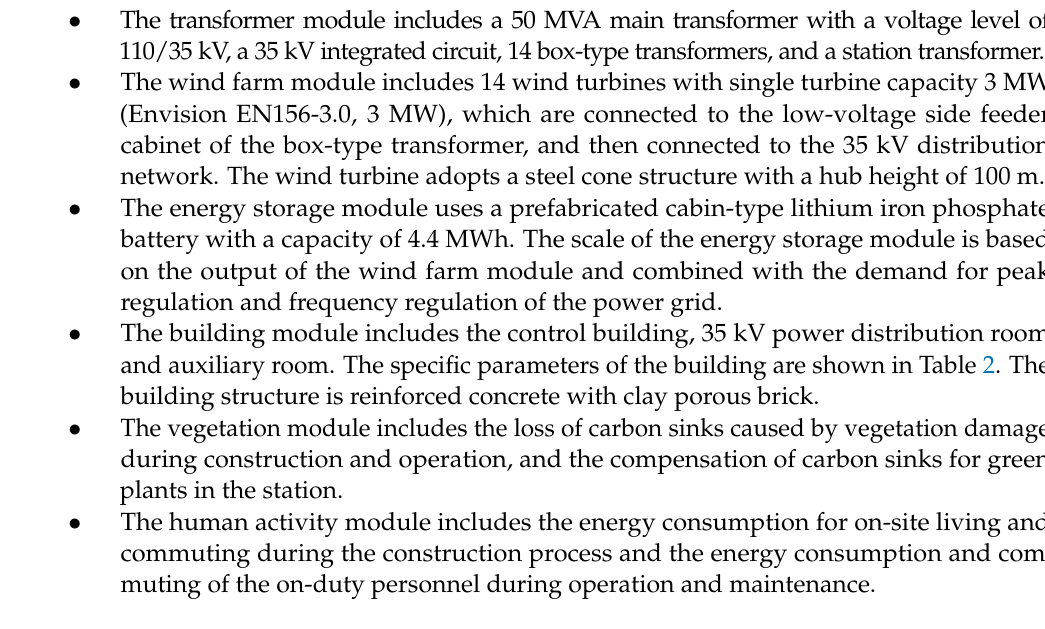
Table 2. Parameters in the building